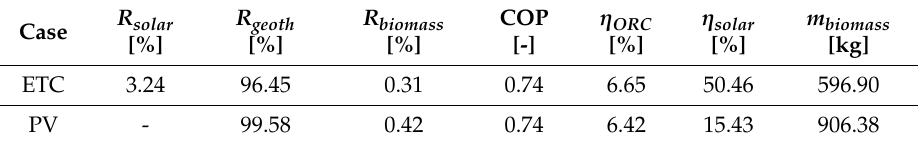
Table 8. Yearly performance